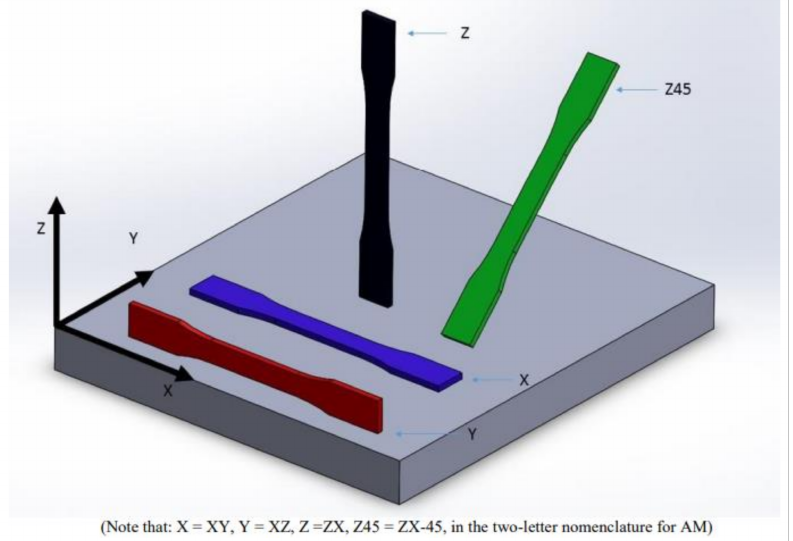
Figure 2. Specimen orientation diagram (permission received from NIAR on 10/29/2021